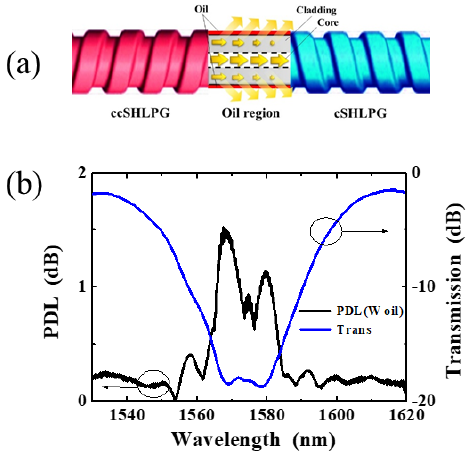
Figure 21. ( a ) Schematic diagram of the proposed polarization-insensitive flat-top rejection filter ( b ) Measurement results for PDL and transmission spectra of the fabricated proposed HLPG-based rejection filter. Reprinted from Ref. [60]. Copyright (2021), with permission from Elsevier.